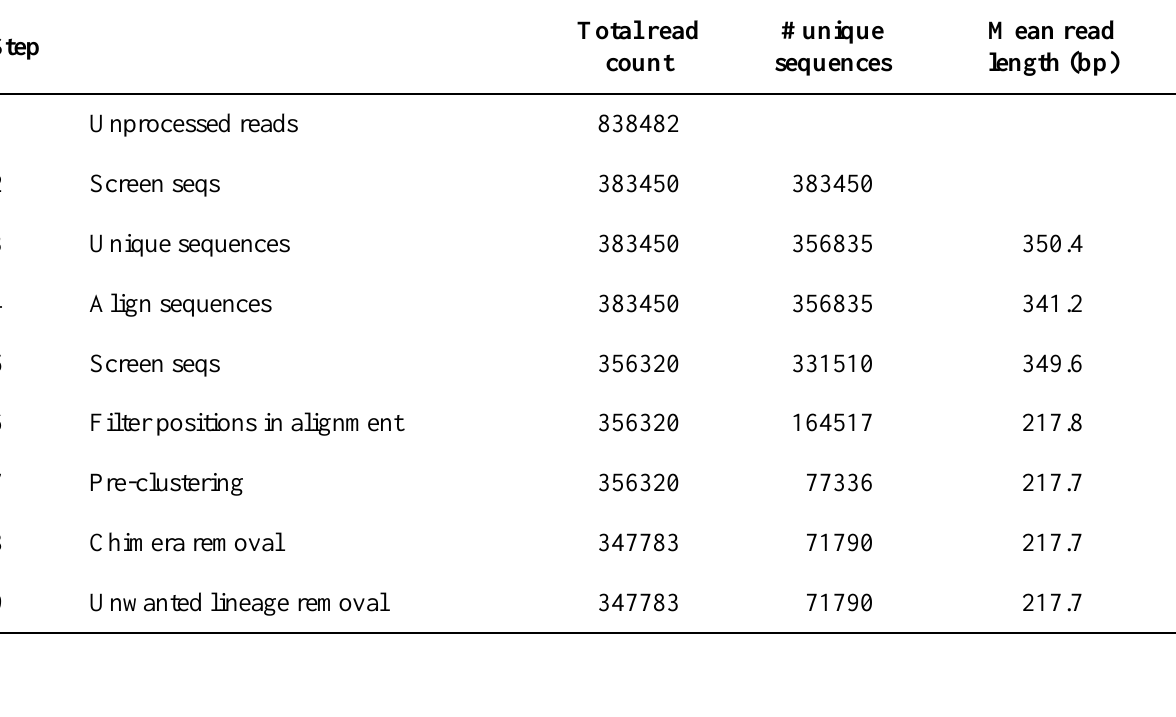
Table A1. Step-by-step overview of sequence read processing.